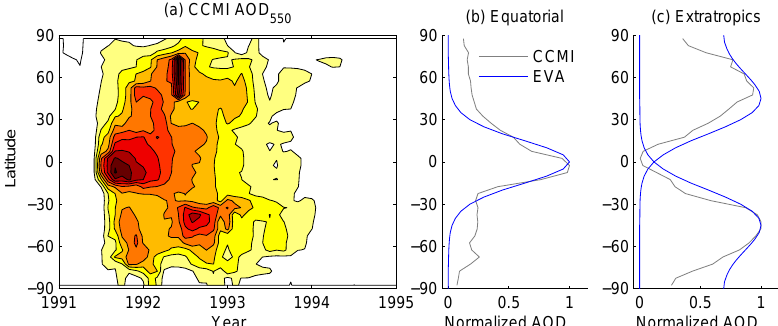
Figure 2. Definition of latitudinal shape functions. (a) The zonal mean CCMI AOD anomaly at 550nm as a function of latitude and time for 4 years. (b) CCMI AOD anomaly averages over the 3 months (gray) after the Pinatubo eruption, normalized by its maximum value. A Gaussian fit to the equatorial portion of the 3-month average (blue) is used to define the latitudinal shape function for the equatorial plume of EVA. (c) The residual of the CCMI 4-year mean AOD minus the EVA equatorial shape function (gray) is used to define the extratropical EVA shape functions